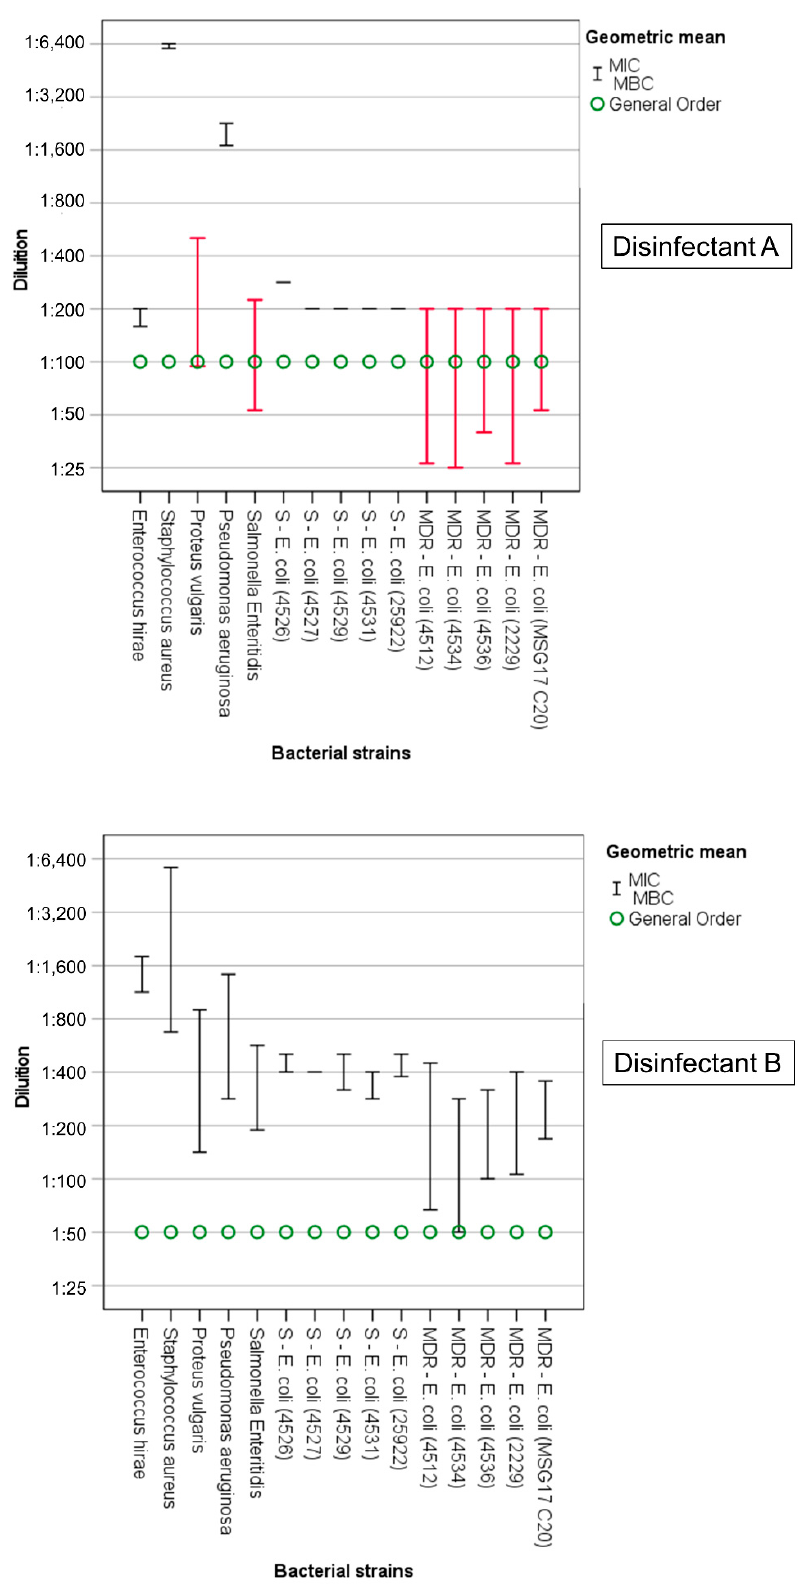
Figure 1. Disinfectant A and disinfectant B. Minimum inhibitory concentration (MIC, upper whisker) and minimum bactericidal concentration (MBC, lower whisker). In red, bacterial strains tolerant to disinfectants (MBC > GO).